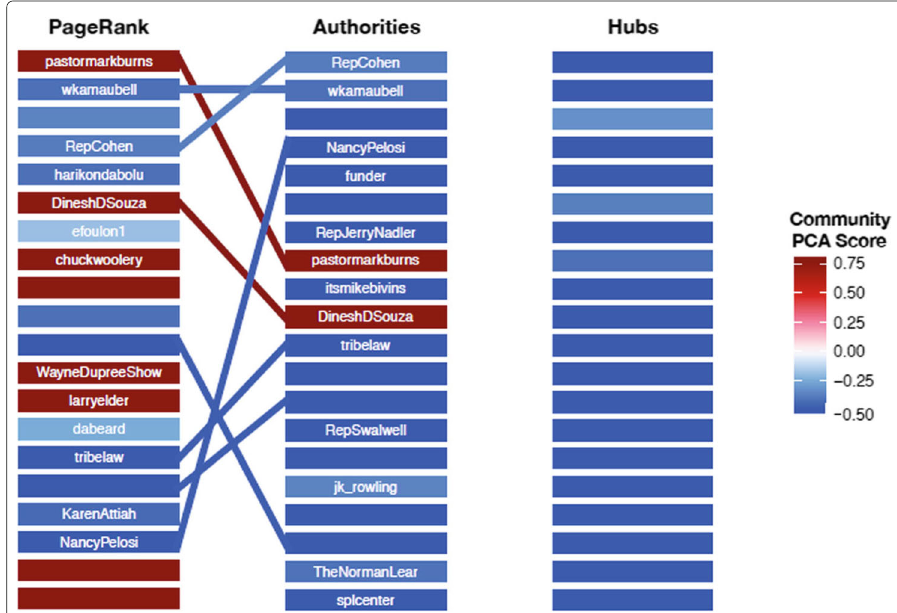
Fig. 3 The 20 most central nodes in the largest weakly connected component of the retweet network according to (left) PageRank, (center) authorities, and (right) hubs. Color corresponds to the mean media PCA score for the community assignment of each node from modularity maximization using a Louvain method (see “Community structure”). We use colored lines to link nodes that appear in more than one column. There is overlap between the nodes with the largest scores for PageRank and authority centrality, but these two sets are disjoint from the accounts with the largest hub centralities. All of the best hubs belong to communities with negative (i.e., Left) mean media PCA